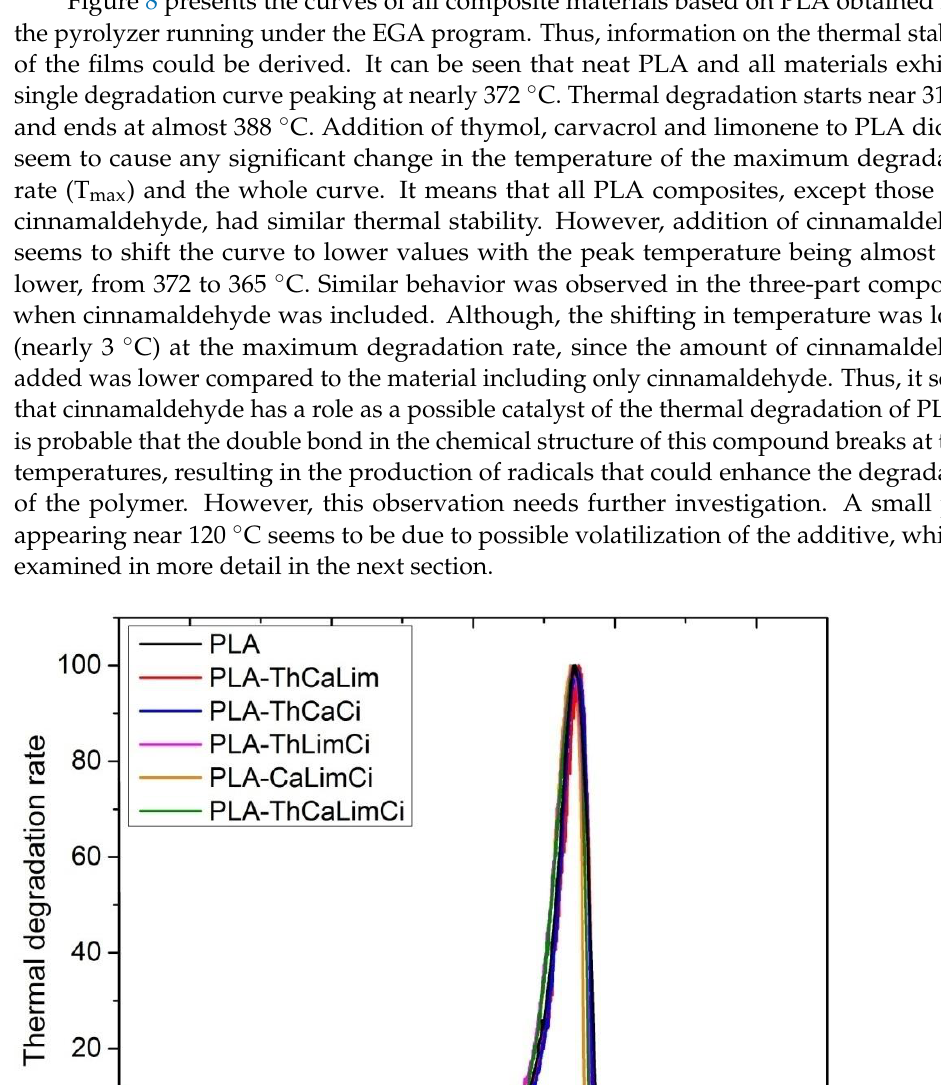
( b ) Figure 8. Thermal degradation under an inert atmosphere of PLA and its composites with a single additive ( a ) or ternary or quaternary composites ( b ) obtained from a pyrolizer using the EGA method. 3.3. Release Profiles of the Active Compounds from the Polymer Matrix and Study of the Process Kinetics Furthermore, in order to check the small degradation peak observed in the cases of the composites with thymol and carvacrol, release profile studies were performed for